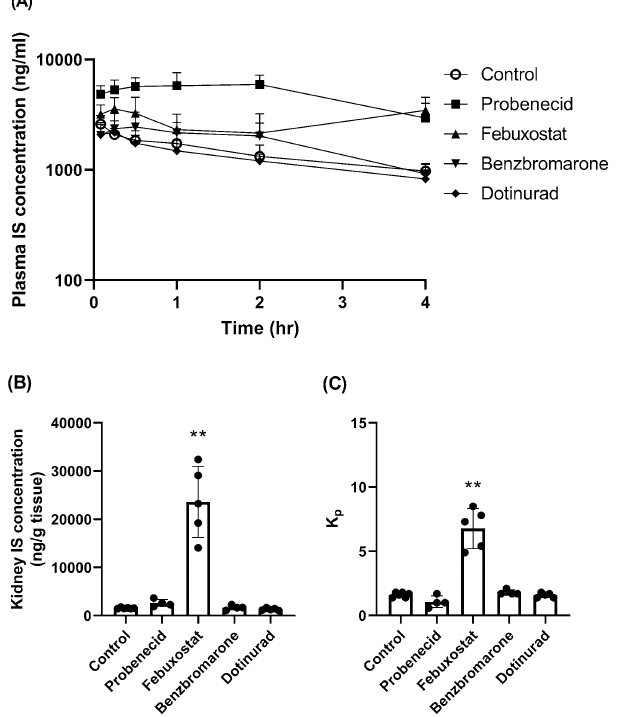
Figure 1. Effect of hypouricemic agents on endogenous IS concentration in the plasma ( A ) and kidney ( B ), and K p ( C ) in intact rats. IS: indoxyl sulfate, K p : kidney-to-plasma partition coefficient. Hypouricemic agents or their vehicles as controls were orally administered to Wistar rats fasted for 16 h. After 30 min, d 4 -IS was intravenously administered. Blood samples were collected at 0.083, 0.25, 0.5, 1, 2, and 4 h after d 4 -IS administration. Plasma samples were deproteinated, and the endogenous IS concentration was measured by LC–MS/MS. Each value is presented as mean + SD ( A ) or mean ± SD with individual dots ( B and C ) of four to six animals. **: P < 0.01, significantly different from the control group according to Dunnett’s multiple comparison test.